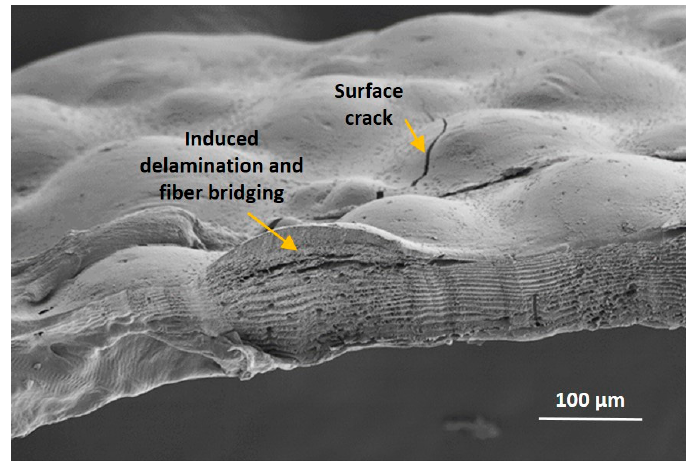
Figure 6. Cracks develop under load on the external surface of the scorpion tibia, which induce multiple interlayer delaminations at various depths in the endocuticle, likely through the Cook–Gordon mechanism [2]; see Figure 1c.